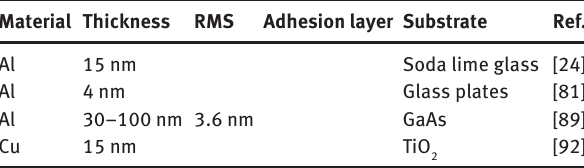
Table 3: Other metallic thin film parameters on different substrates and using various adhesion